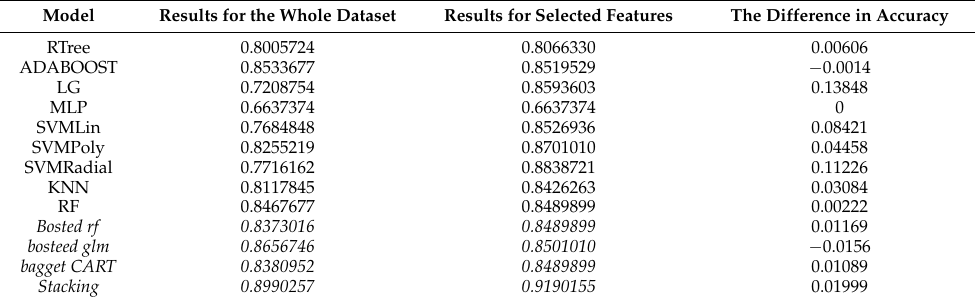
Table 4. Models’ comparison (accuracy).